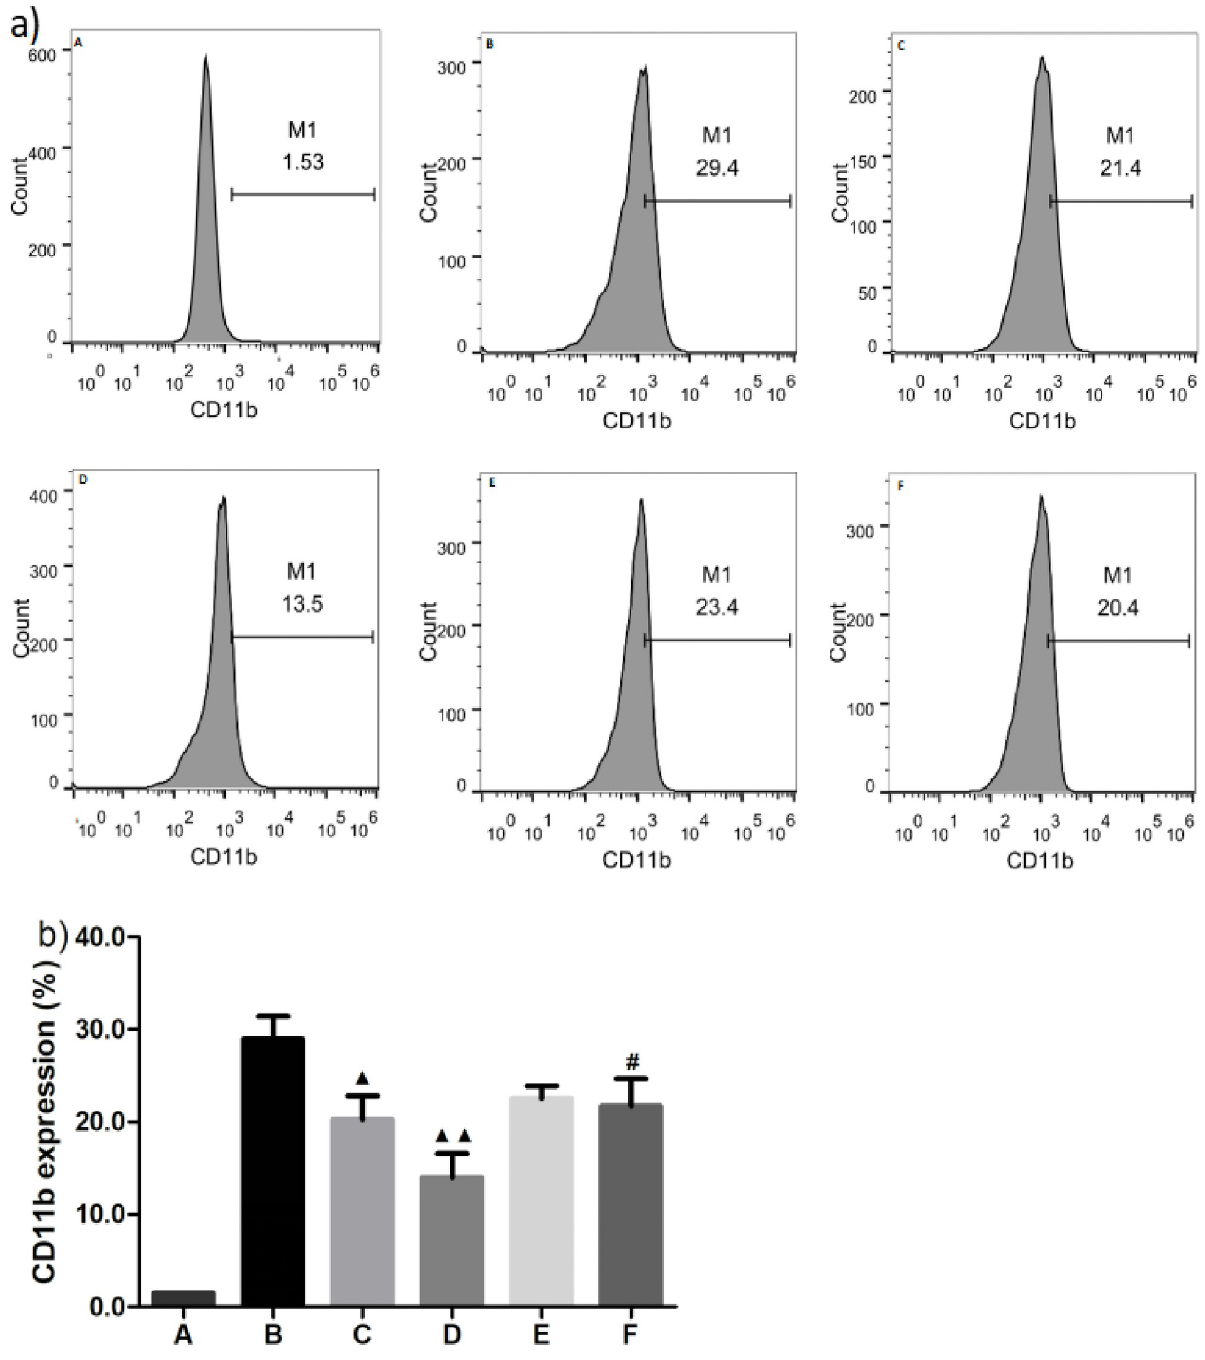
Fig 4. Effects of papain and miRNA-146a inhibitors on CD11b expression of activated monocytes mediated by MPA formation. ( � x ± s , n = 3). a) Gating strategy for quantification of Mac-1 in a co-culture system of THP-1 cells and activated platelets by flow cytometry (FCM). Mac-1 was evaluated by expression of CD11b in THP-1 cells mediated by monocyte-platelet attachment following treatment with 100 or 200 U/L of papain with or without miRNA-146a. A: isotype control; B: negative control; C: 100 U/L of papain; D: 200 U/L of papain; E: 100 U/L of papain combined miRNA- 146a inhibitors; F: 200 U/L of papain combined miRNA-146a inhbitors. ▲ , # P < 0.05 compared with negative control and 200 U/L papain group, and ▲▲ P < 0.01 compared with negative control, as analyzed by LSD- t test.